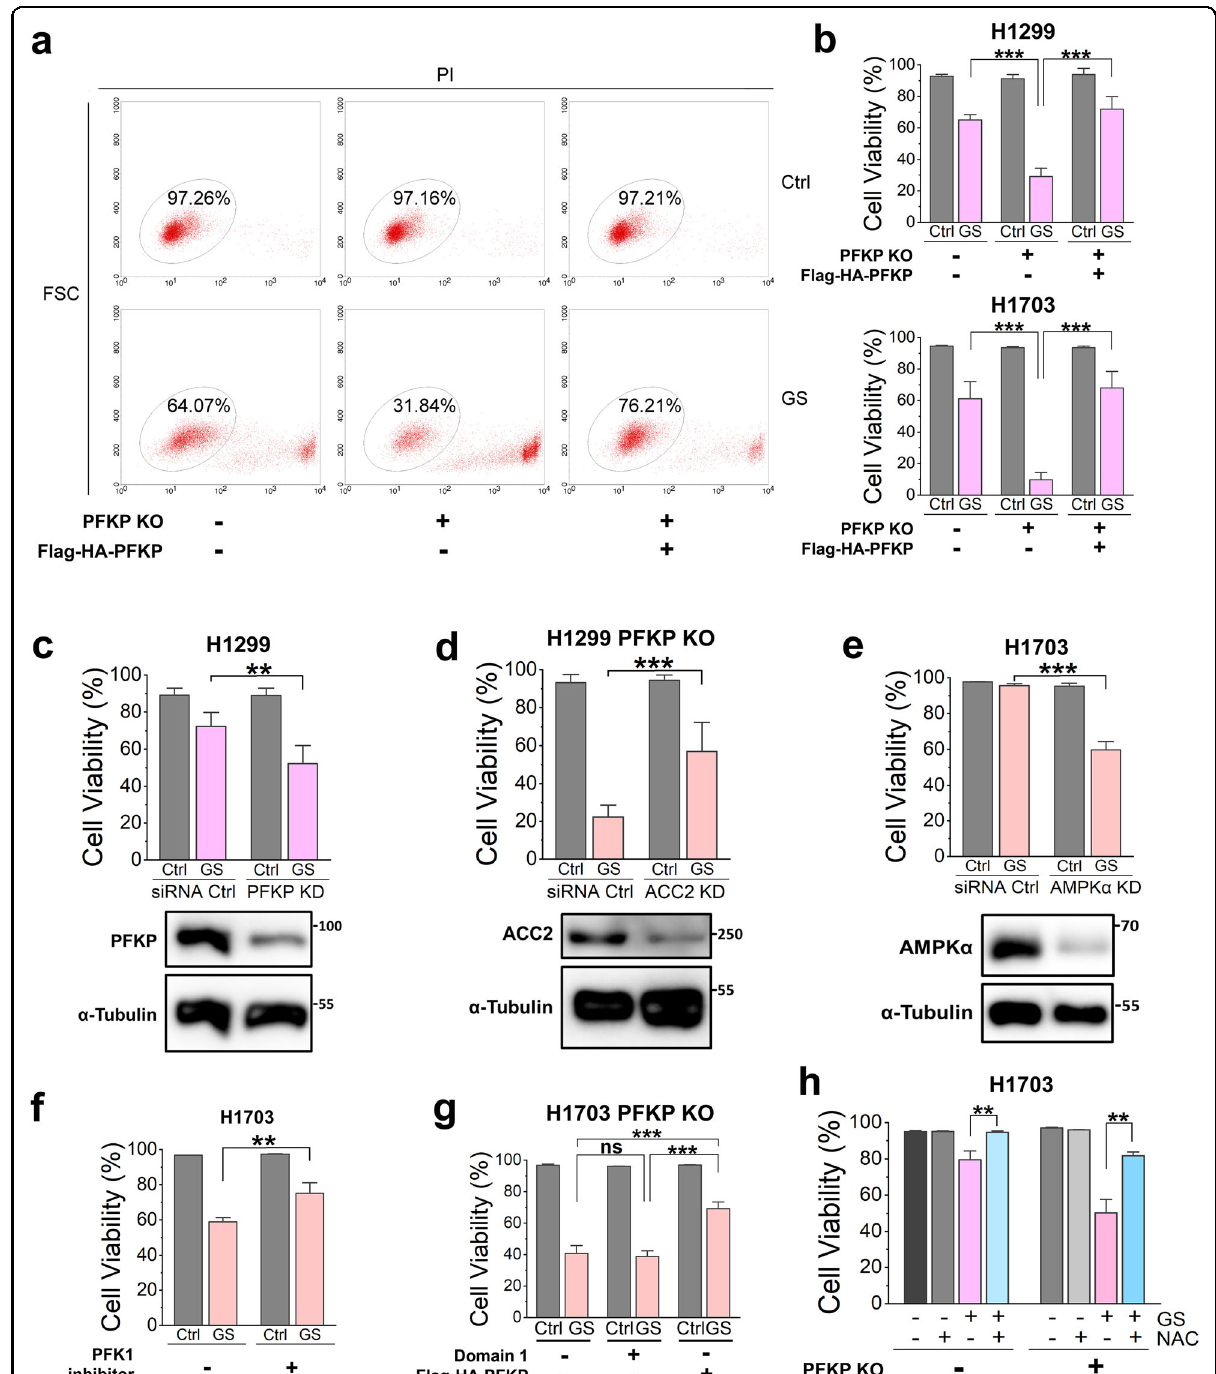
Fig. 6 PFKP promotes NSCLC cell survival under GS via long-chain fatty acid oxidation. a Propidium iodide (PI) exclusion test of H1299 cells under control (Ctrl) or GS for 48 h. FSC: forward scatter. b Cell viability of H1299 ( n = 9) or H1703 cells ( n = 8) under control (Ctrl) or GS for 48 h. c Cell viability of H1299 with PFKP knock-down (KD) ( n = 5) under control (Ctrl) or GS for 48 h. d Cell viability of H1299 KO cells with ACC2 KD ( n = 9) under control (Ctrl) or GS for 48 h. e Cell viability of H1703 cells with AMPK α KD ( n = 4) under control (Ctrl) or GS for 8 h. f Cell viability of H1703 cells treated with 1 mM PFKP inhibitor 2,5-Anhydro-D-glucitol-1,6-diphosphate ( n = 4) under control (Ctrl) or GS for 24 h. g Cell viability of H1703 PFKP KO cells transfected with empty vector, Domain 1, or Flag-HA tagged PFKP ( n = 4) under control (Ctrl) or GS for 24 h. h Cell viability of H1703 treated with 5 mM N-acetylcysteine (NAC) ( n = 4) under control (Ctrl) or GS for 24 h. Data are shown as means ± SD with n indicating the number of biological replicates. * P < 0.05, ** P < 0.01, *** P < 0.001 by two-tailed Student ’ s t